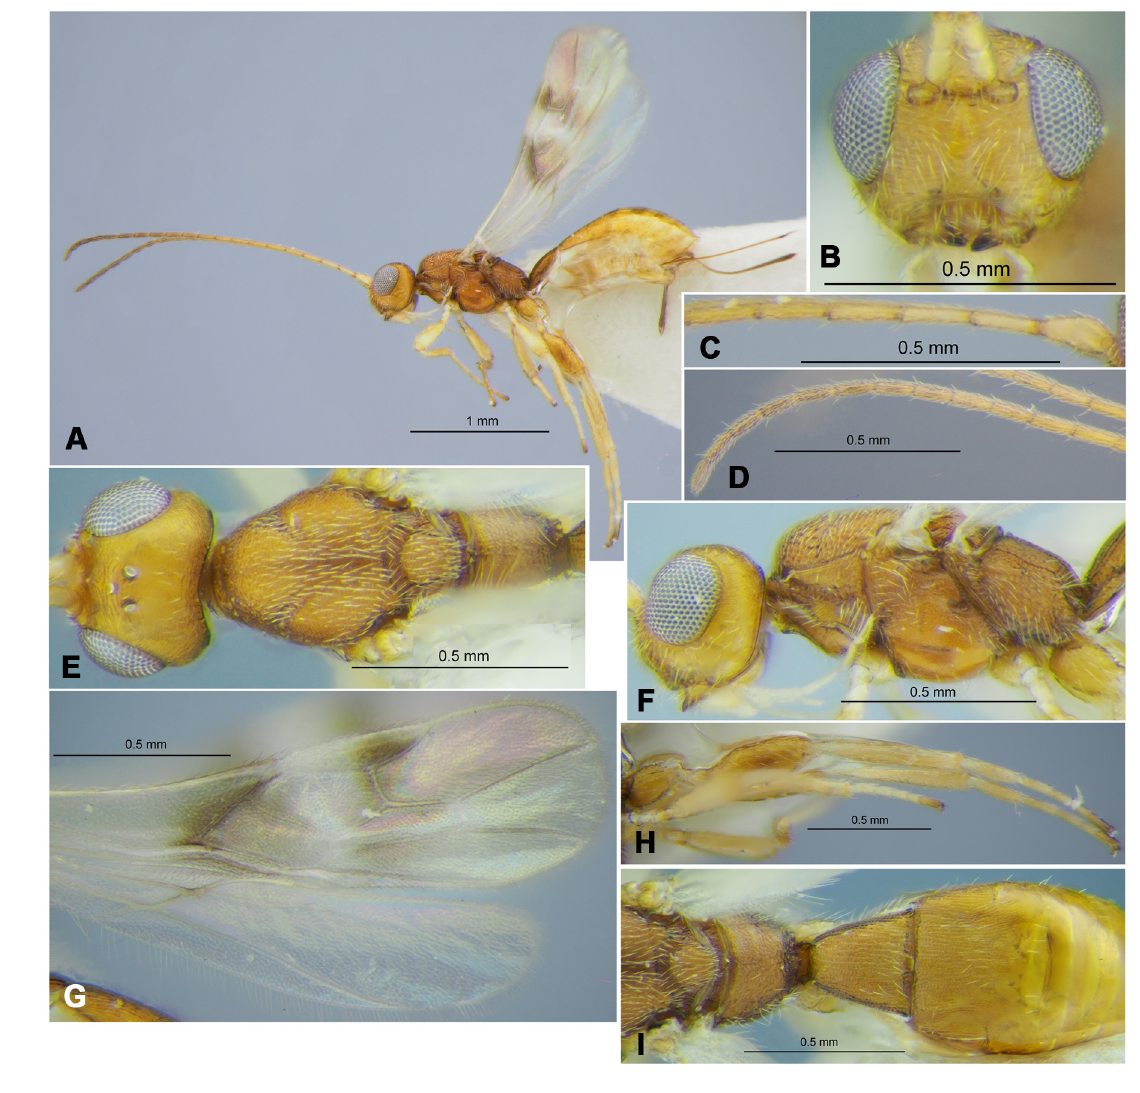
Fig. 3. Dendrosotinus ( Gildoria ) maculipennis Belokobylskij sp. nov., holotype, ♀ (RMNH). A . Habitus, lateral view. B . Head, front view. C . Basal segments of antenna. D . Apical segments of antenna. E . Head and mesosoma, dorsal view. F . Head and mesosoma, lateral view. G . Wings, distal part. H . Hind leg. I . Propodeum and basal part of